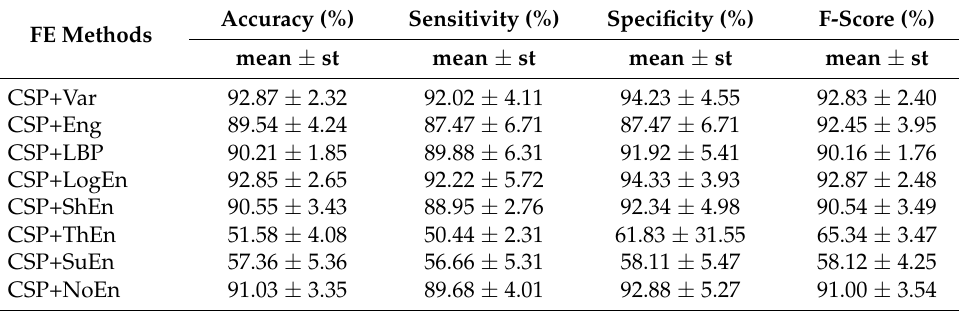
Table 9. Classification results of on–PD vs. HC using KNN classifier.